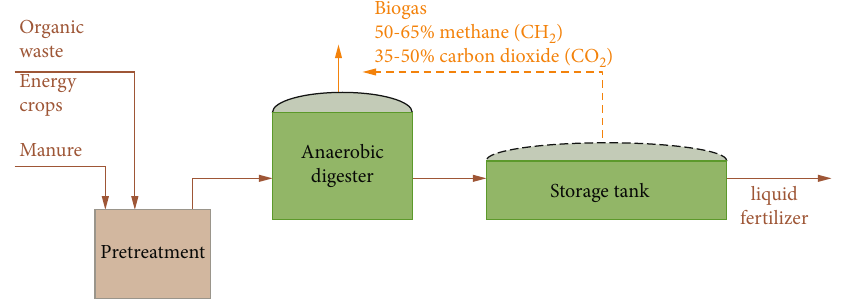
Figure 1: Biogas and fertilizer production.